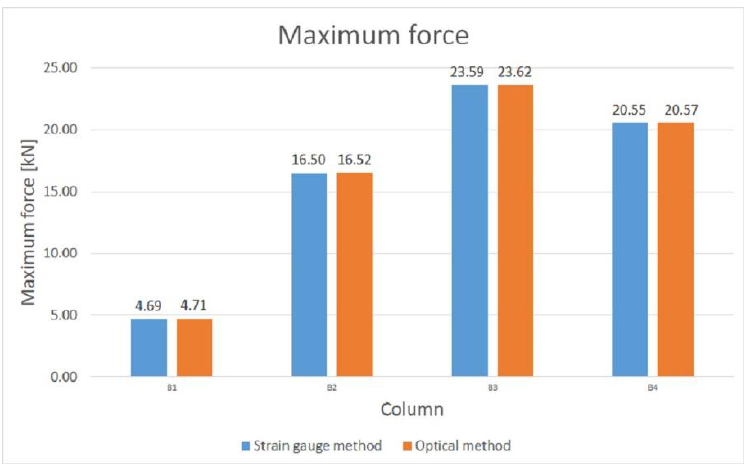
Figure 15. Comparison of maximum forces obtained using strain gauge and optical methods.